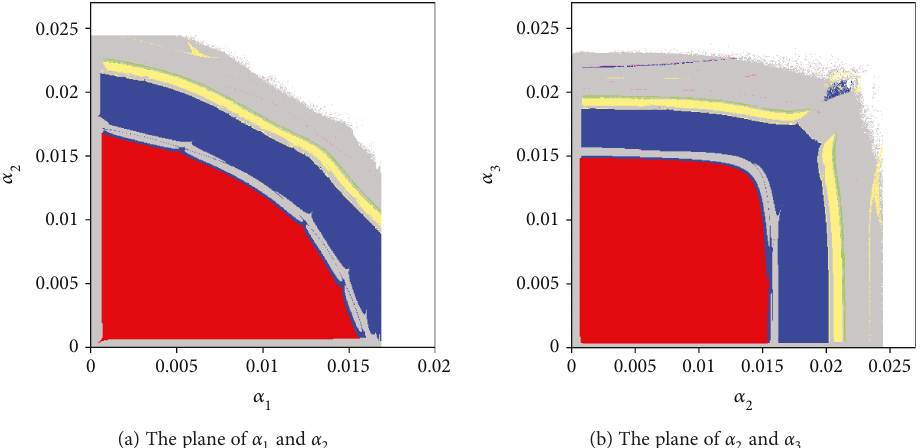
Figure 7: The 2D bifurcation diagram of system (12).